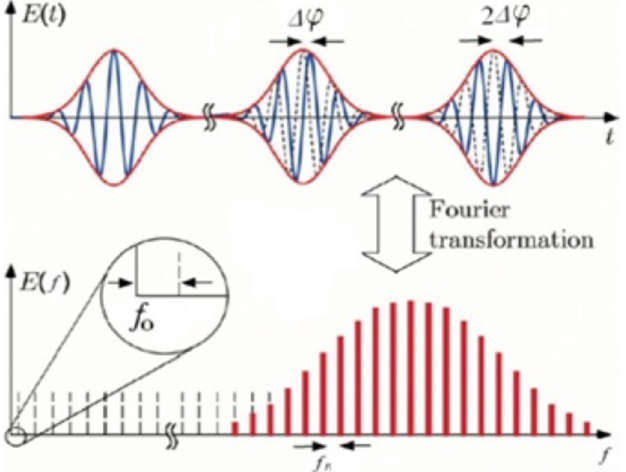
Fig. 1. Representation of the output fi eld of a mode-locked laser in domain time and the corresponding spectrum.